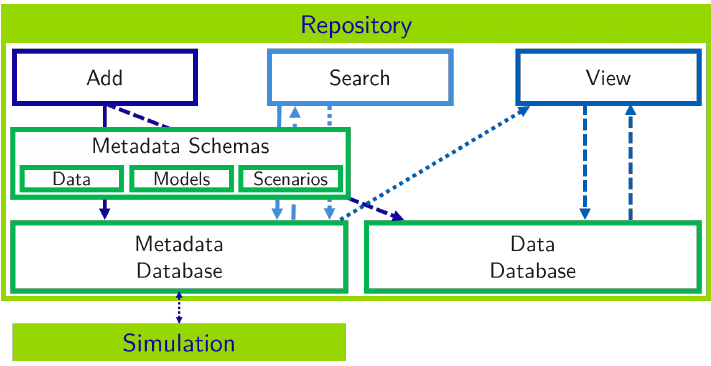
Figure 5. Basic functionalities of Repository and their